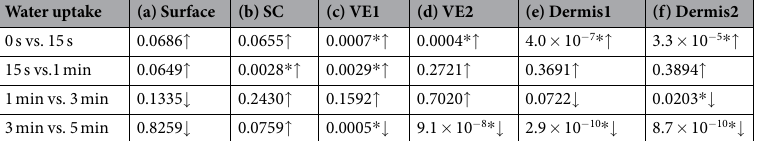
Table 1. Probability results (P-value) of unpaired student’s t-tests on water uptake between different exposure times at different layers. * Significant changes ( p < 0.05). ( a ) 0 µ m ( b ) 4 µ m ( c ) 40 µ m ( d ) 60 µ m ( e ) 100 µ m ( f ) 120 µ